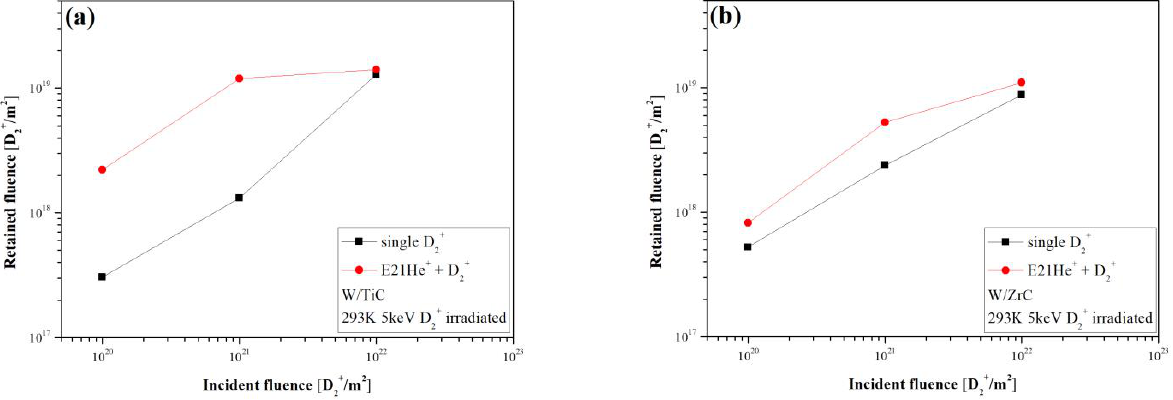
Figure 10. Retained deuterium amount for both material types as a function of fluences of D 2+ ion implantation after pre-irradiation by 5 keV 1.0 × 10 21 He + /m 2 at RT: ( a ) W-1wt%TiC, ( b ) W-1wt%ZrC.